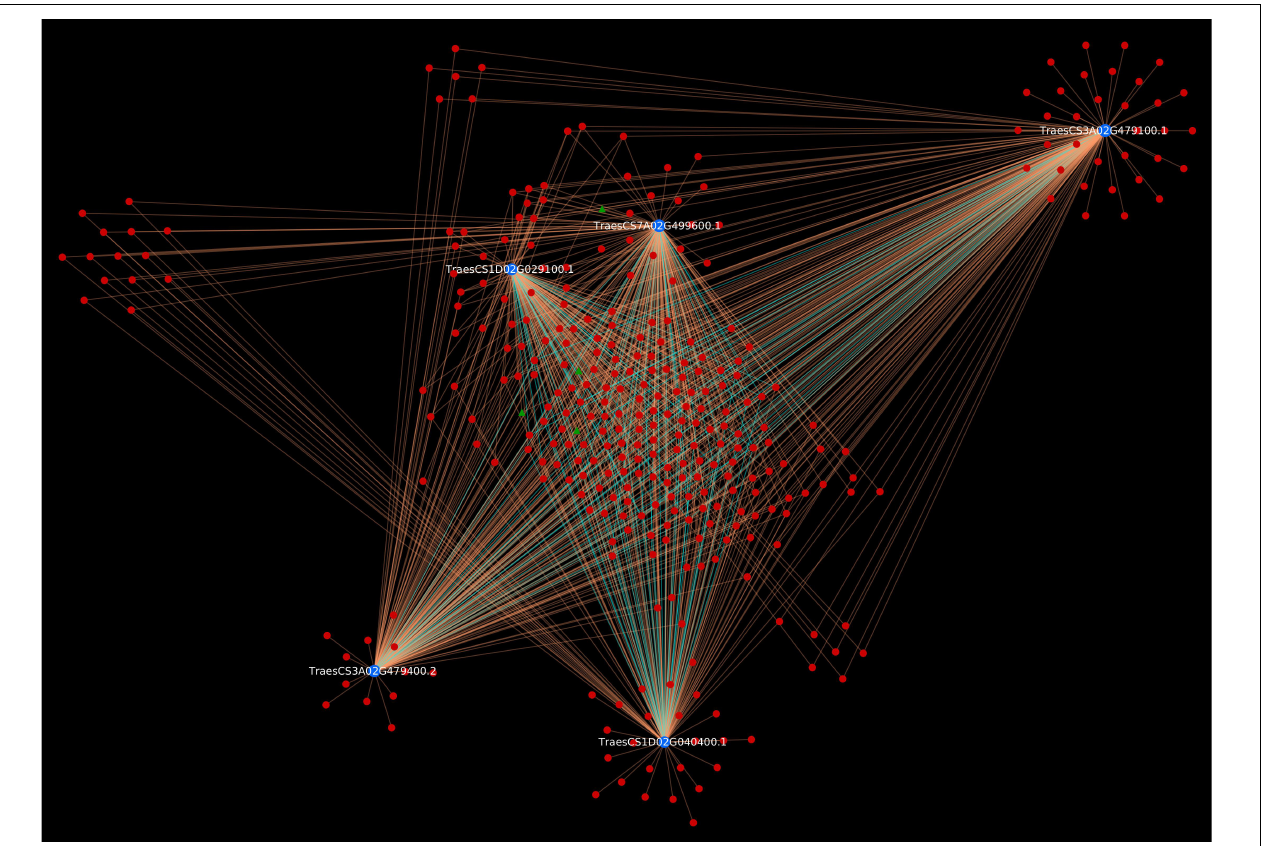
FIGURE 7 | Stem rust resistance gene complex ( Sr22 , Sr33 , Sr35 , and Sr45 ) causing resistance against TTKSK race. Blue nodes represent host proteins, red nodes are pathogen proteins, and green nodes are effector proteins. Orange edges depict the interactions from interolog-based approach, while cyan edges belong to domain-based